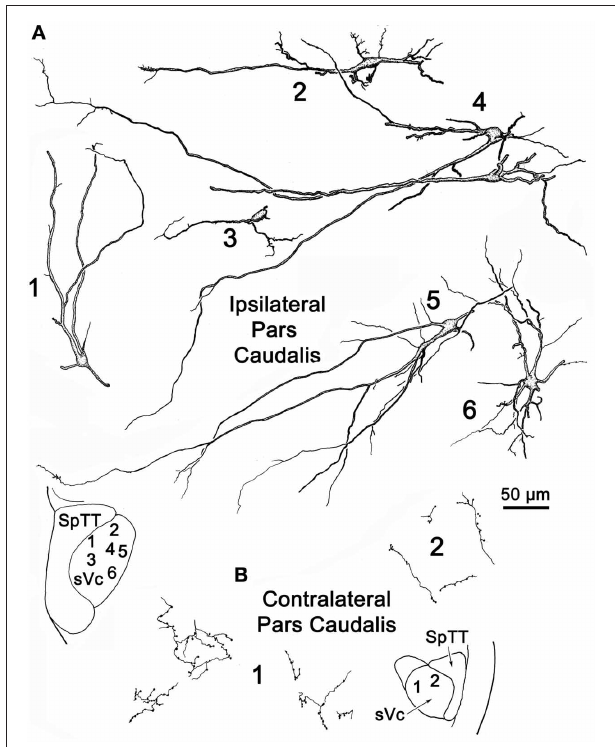
FIGURE 4 | Retrogradely labeled neurons and anterogradely labeled axons within the sVc on the ipsilateral (A) and contralateral (B) side following the injection illustrated in Figure 2A. Labeled intratrigeminal neurons were only seen ipsilaterally (A) , not contralaterally (B) . The location of the illustrated neurons is shown in the low magnification